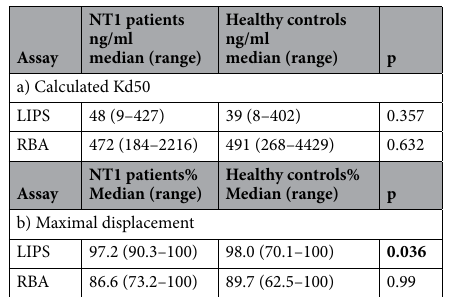
Table 2. Affinity analysis of A/H1N1 HA antibodies. Calculated Kd50 values ( a ) and maximal displacement ( b ) of A/H1N1 HA antibodies in a subset of subjects from the exploratory cohort described in Fig. 2, using the